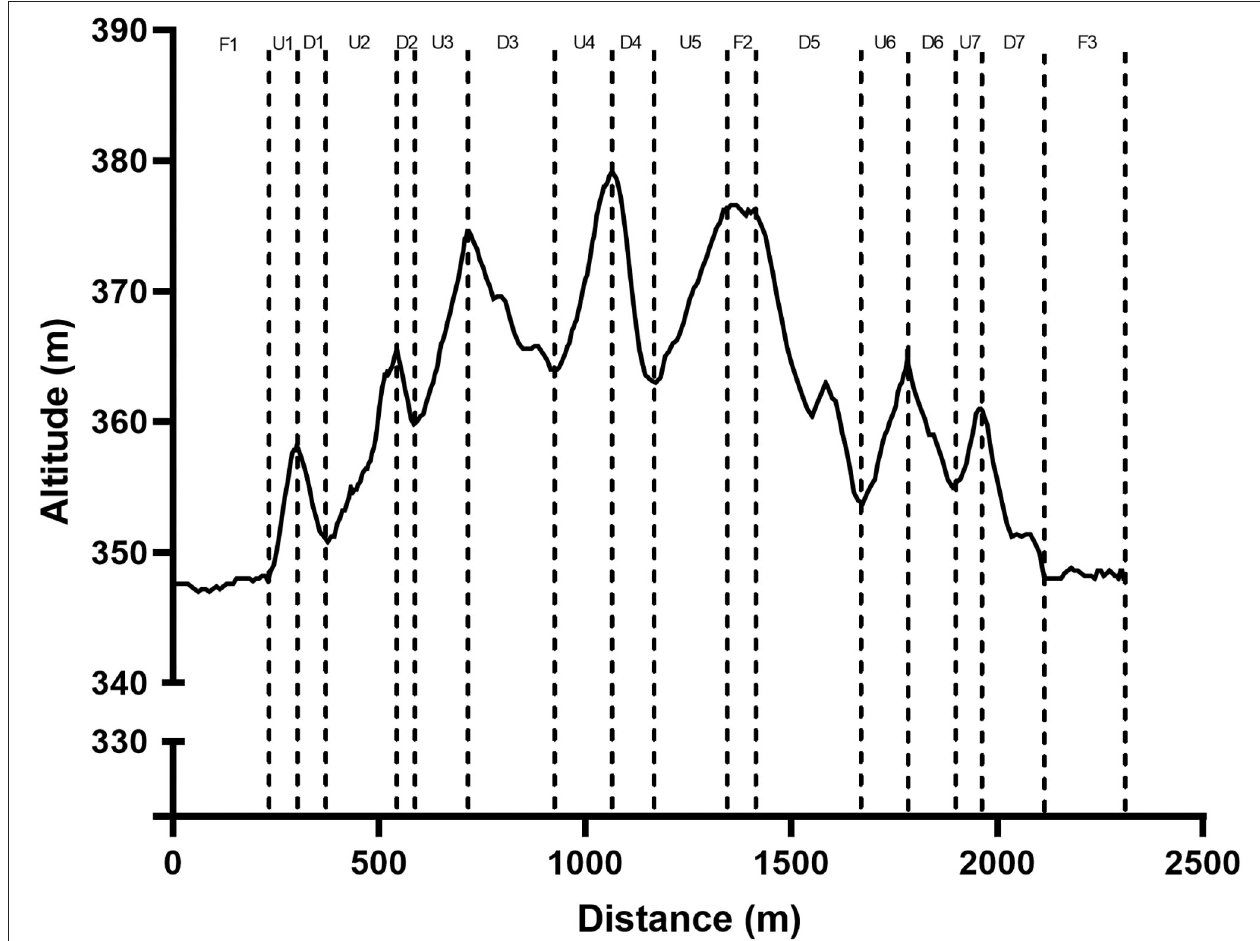
FIGURE 2 | Course profile including Uphill, Flat and Downhill sections. U, Uphill; F, Flat; D,